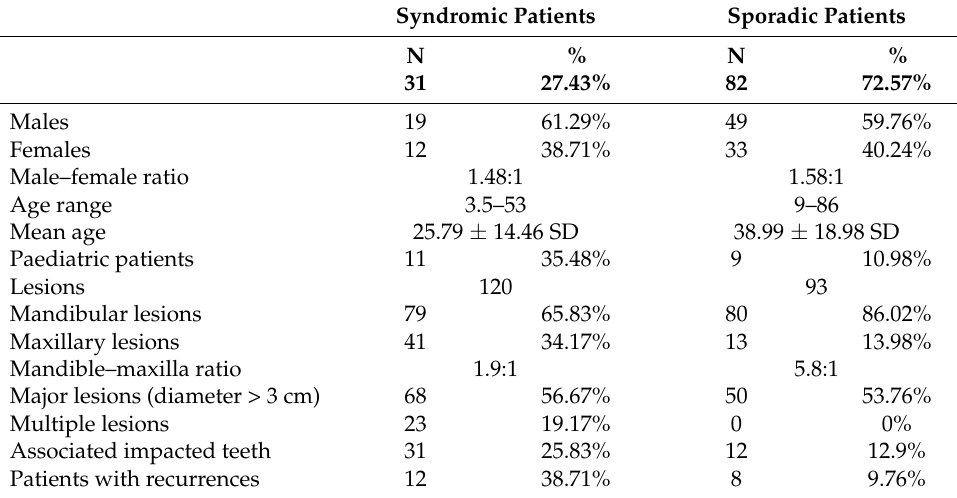
Table 1. Clinical data of the 113 patients included in this